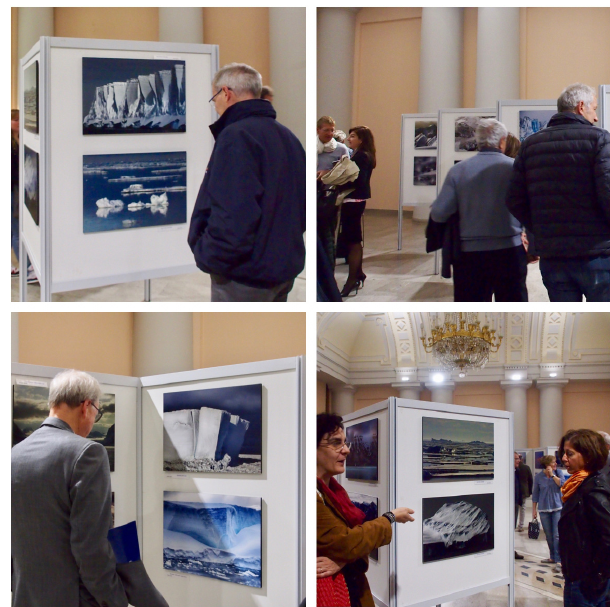
Figure 2. Working-age visitors and the photographs displayed dur- ing the